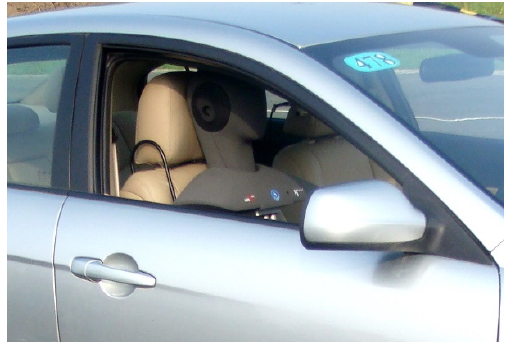
Figure 2. Measurement position of the artificial head.